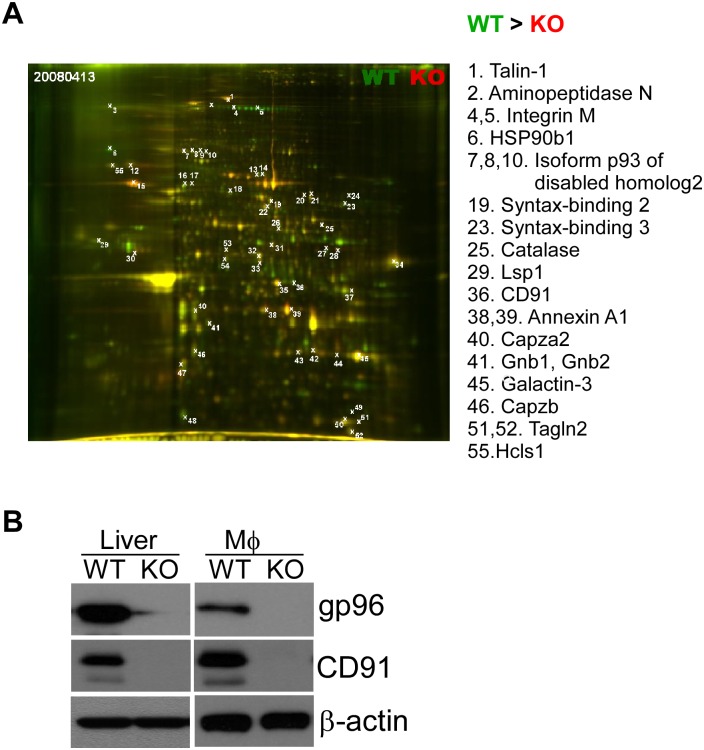
2-D electrophoresis identify CD91 as a novel interactor of gp96.A) Overlay of WT (green) and KO (red) plasma membrane proteins from macrophages after 2-D gel electrophoresis. 55 spots were analyzed, and reduced proteins in gp96 KO BMDMs were listed with the corresponding spot numbers. B) Proteins were extracted from both liver and Macrophage (Mø) of gp96 WT or KO mice. CD91, gp96 and β-actin were immunoblotted. β-actin was a loading control. Data are representative of three experiments.